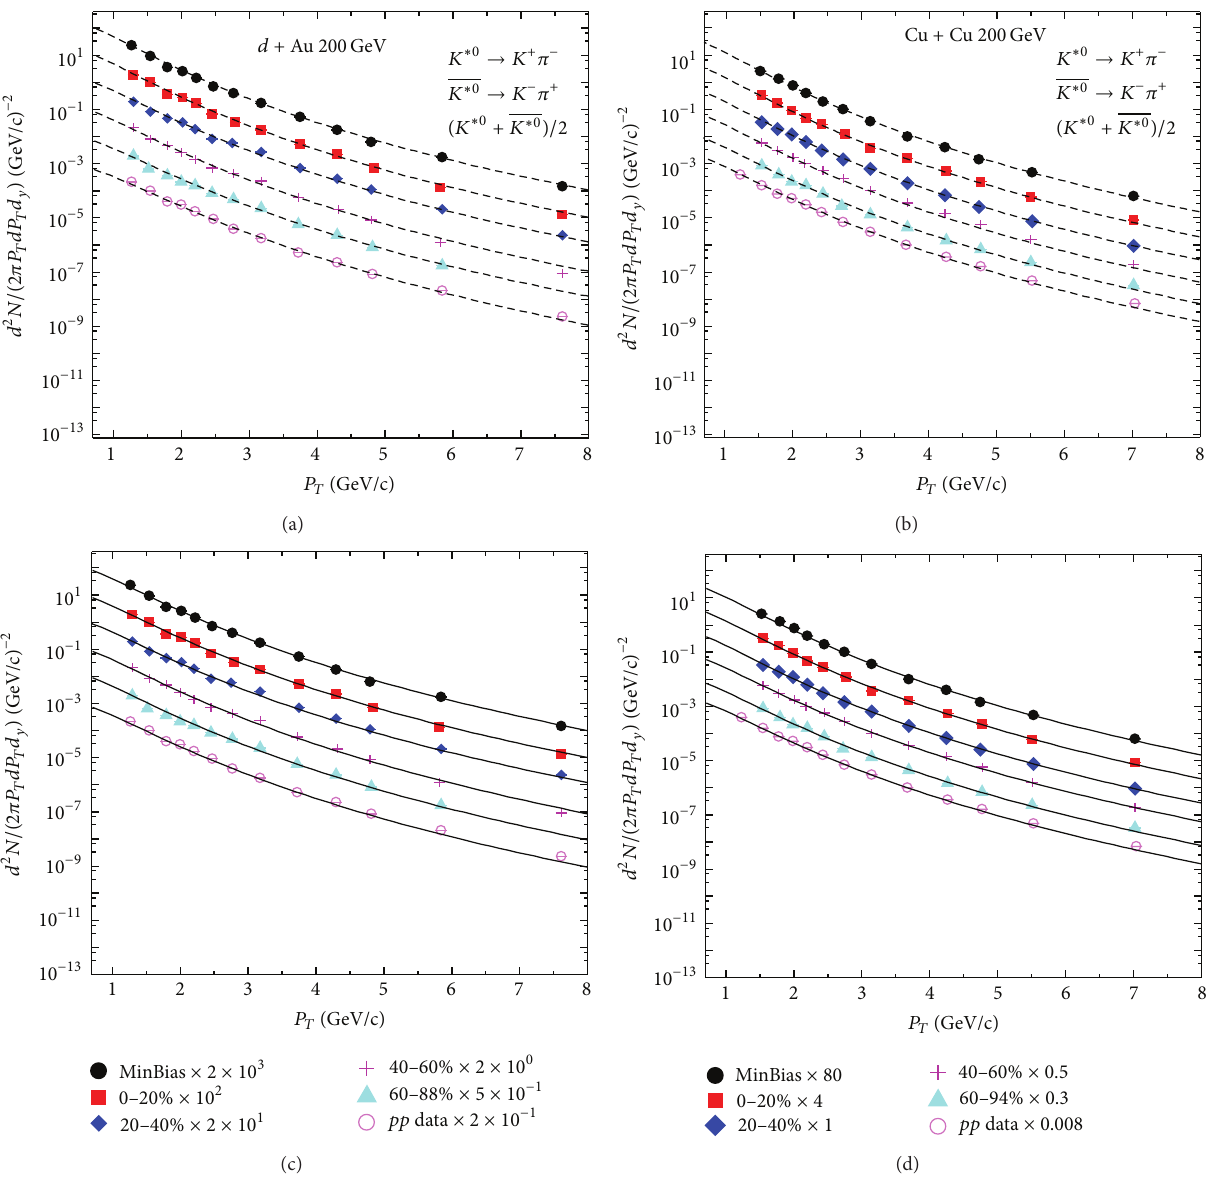
Figure 2: 𝐾 ∗0 and 𝐾 ∗0 transverse momentum spectra in 𝑑 + Au and Cu + Cu collisions for different centrality bins and 𝑝 + 𝑝 collisions at √𝑠 = 200 GeV. Experimental data [11–15] are shown with different symbols. The dashed lines and solid lines are the results of (4) and (5), 𝑁𝑁